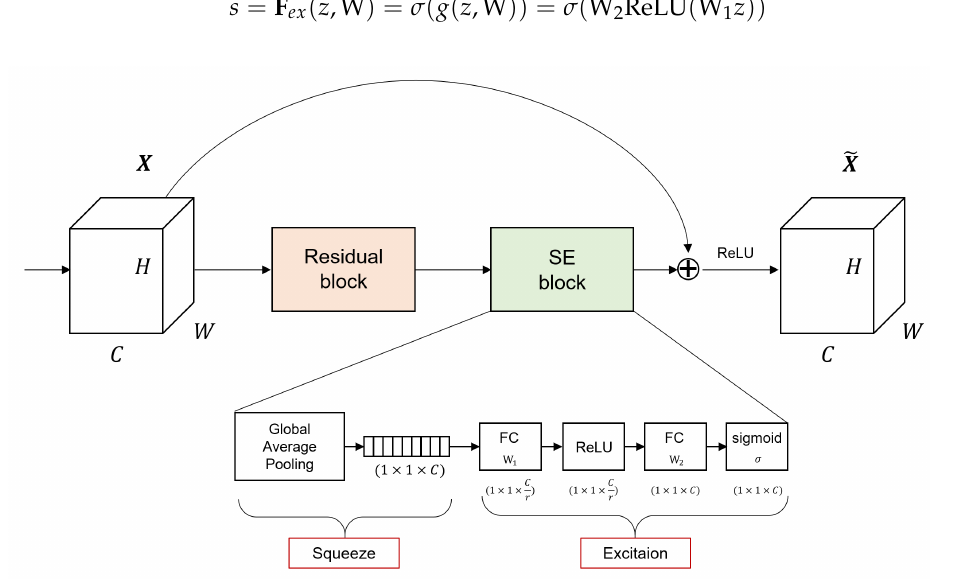
Figure 2. The SE-ResNet structure is configured by adding SE block to ResNet used in this